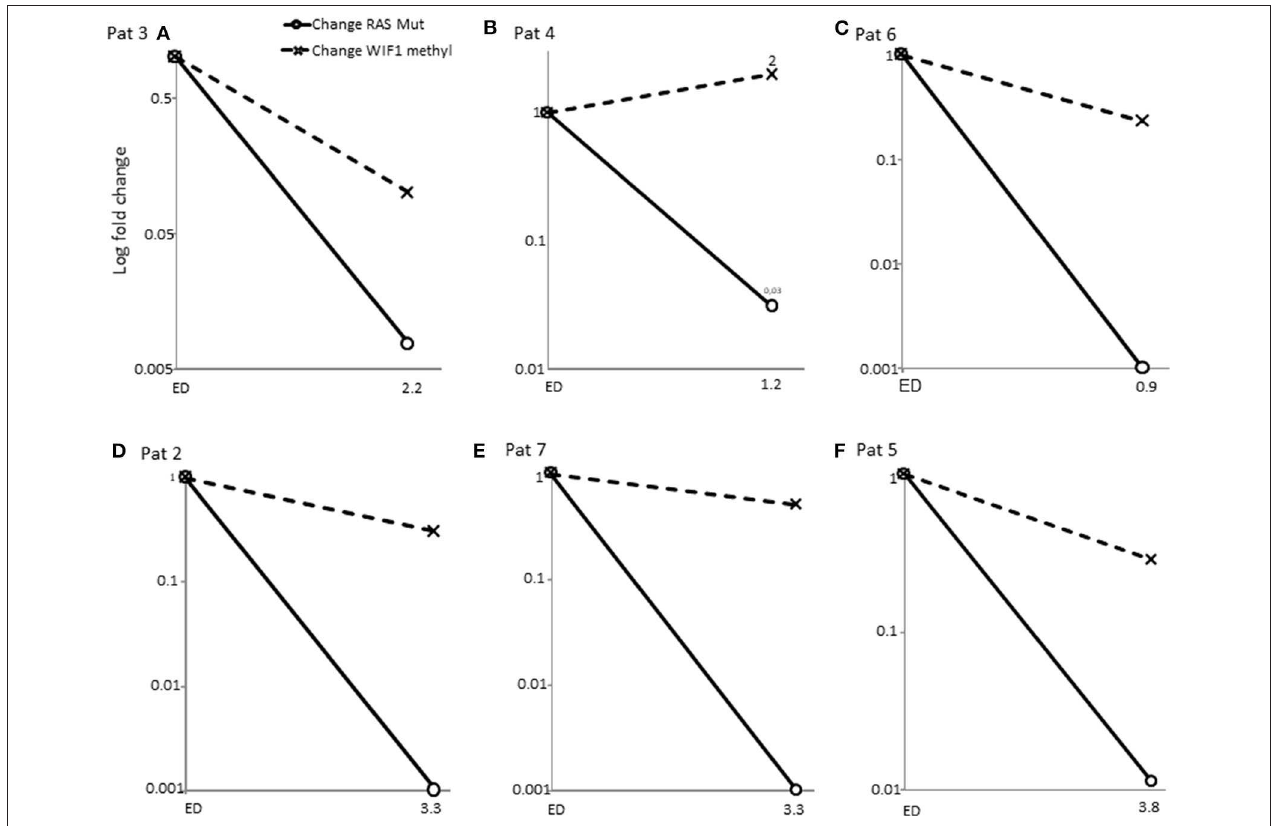
FIGURE 3 | Change of WIF1 promotor methylation proportion vs. change of RAS mutational allele frequency. Samples of patients at the diagnosis time points vs. samples of the time point of disappearance of RAS mutations were measured by methylation specific ddPCR (see Supplementary File ). WIF1 promotor methylation proportion remained detectable in samples with massive RAS MAF% reduction. (A–F) (solid line with circle, change of RAS mutant allele frequency; dashed line with cross, change of WIF1 promotor methylation